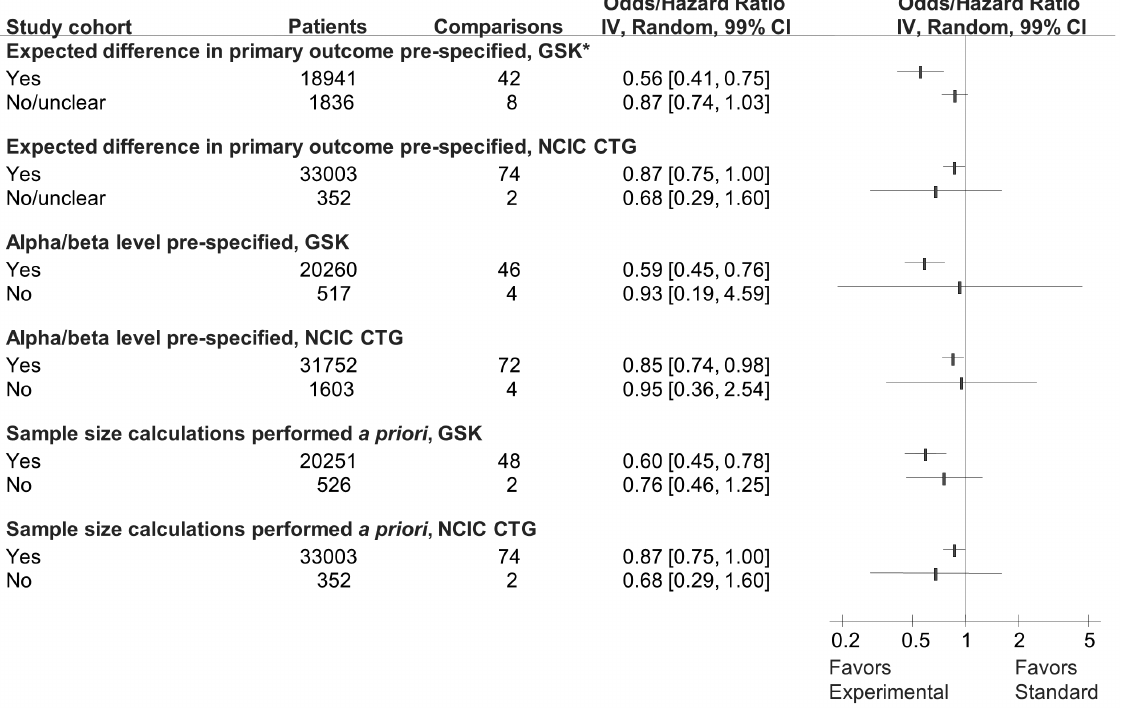
Figure 7. Forest plot of sensitivity analysis for distribution of success rate according to elements of random error that can potentially impact outcomes for GlaxoSmithKline (GSK) and National Cancer Institute Canada Clinical Trials Group (CTG) cohorts. The summary pooled estimate (odds/hazard ratio) is indicated by rectangles, with the lines representing 99% confidence intervals (CIs). * Represents a statistically significant test for interaction between subgroups. The test for interaction was statistically significant in cohort of GSK trials reporting versus not reporting expected difference for primary outcome.